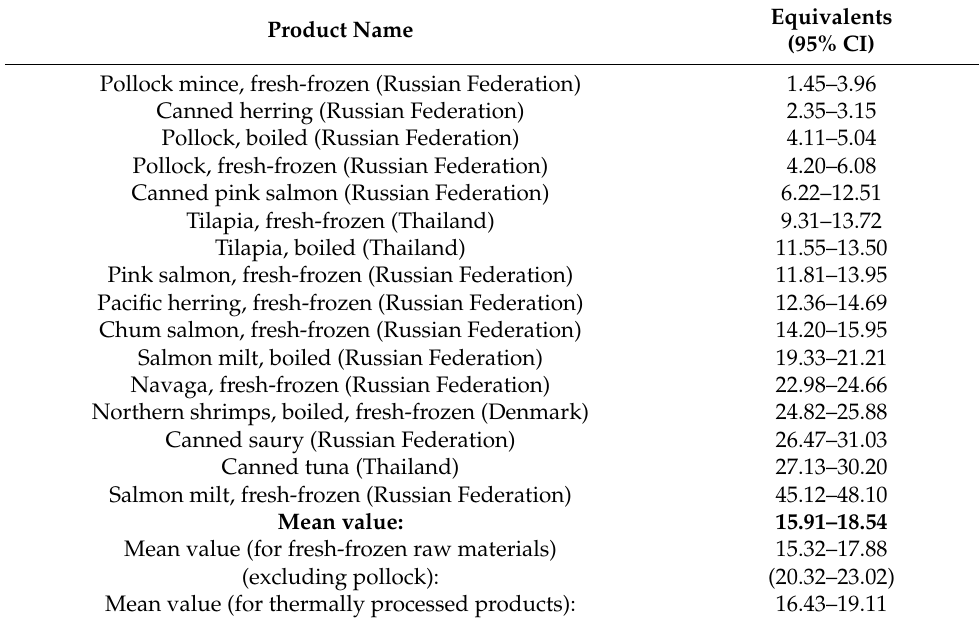
Table 9. Data on ARP for products from fish, fish raw materials, and aquatic biological